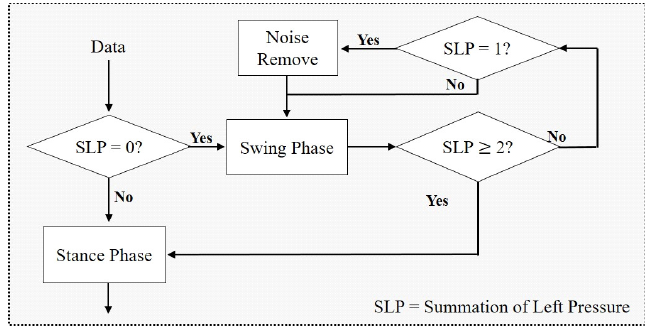
Figure 4. Flow of noise reduction in the swing